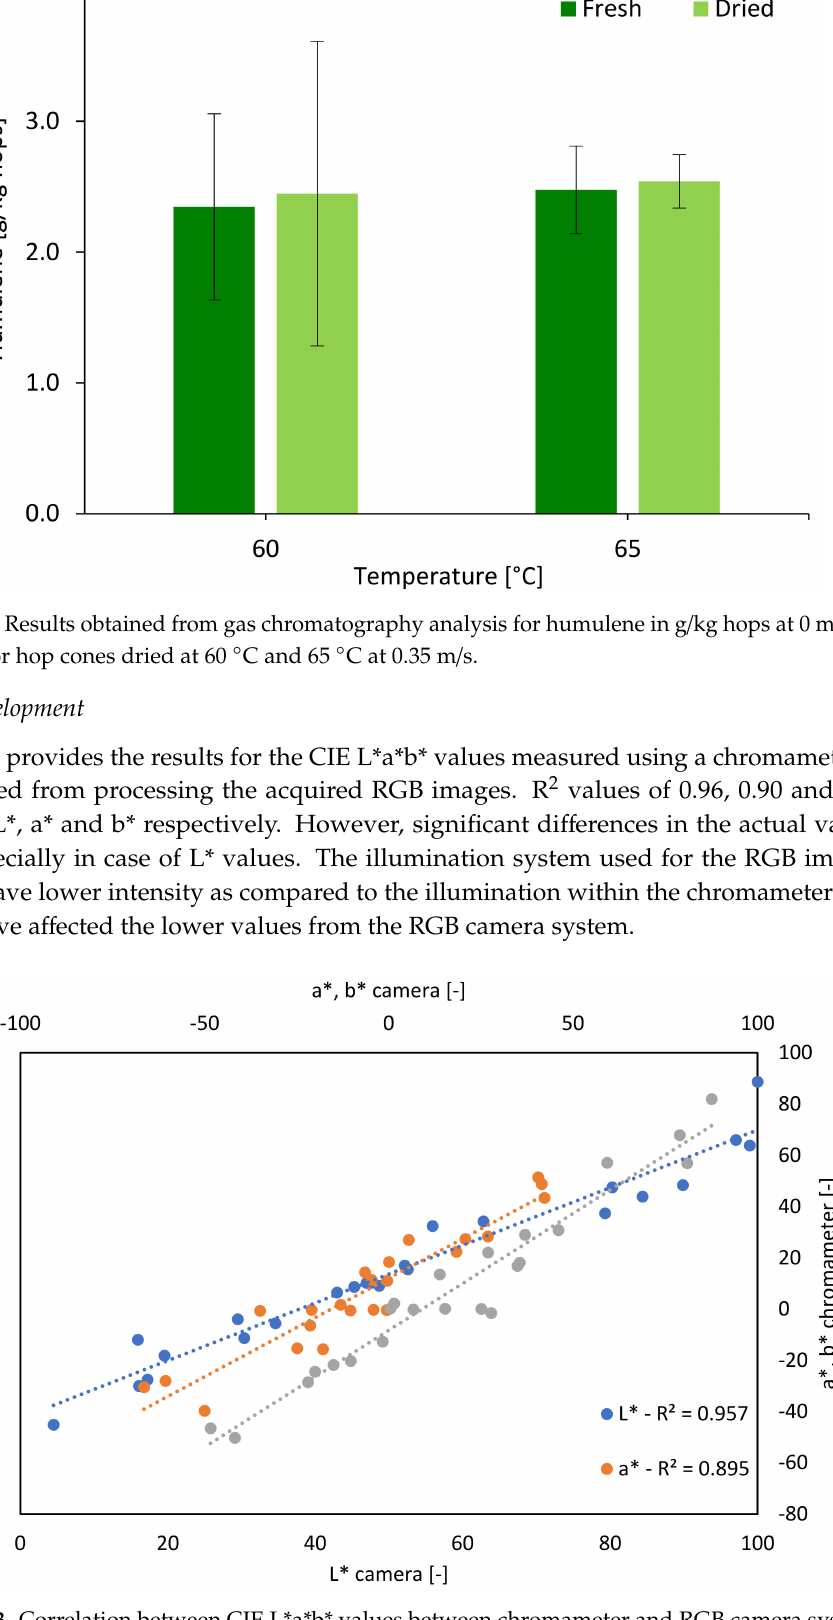
Figure 13. Correlation between CIE L*a*b* values between chromameter and RGB camera